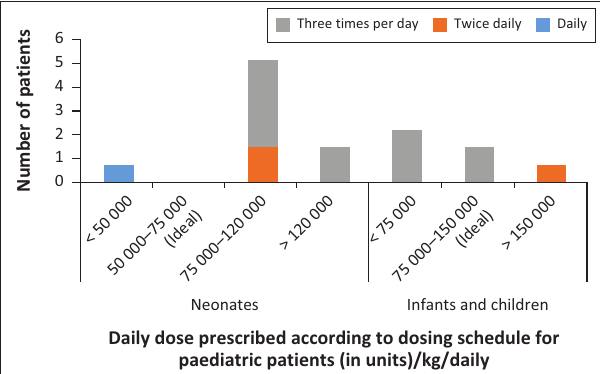
FIGURE 1: Doses of colistin administered in paediatric